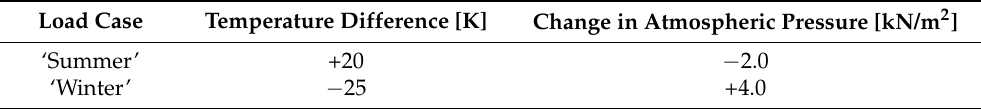
Table 2. Comparison of measured and simulated values of internal pressure in the IGU cavity. Loading (Air Injec- Internal Pressure [Pa] Difference